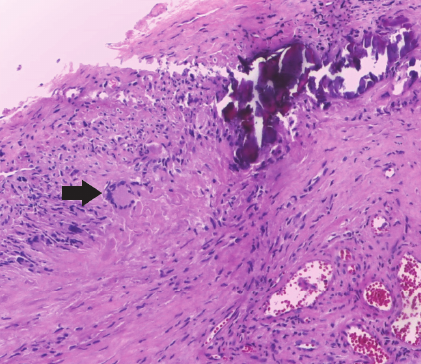
Figure 2: Histological appearance of temporal artery biopsy, show- ing places of dystrophic calcinosis, extensive transmural infiltrate of lymphocytes, and histiocytes with giant cell (black arrow) placed adjacent to internal elastic lamina (haematoxylin and eosin, original magnification ×